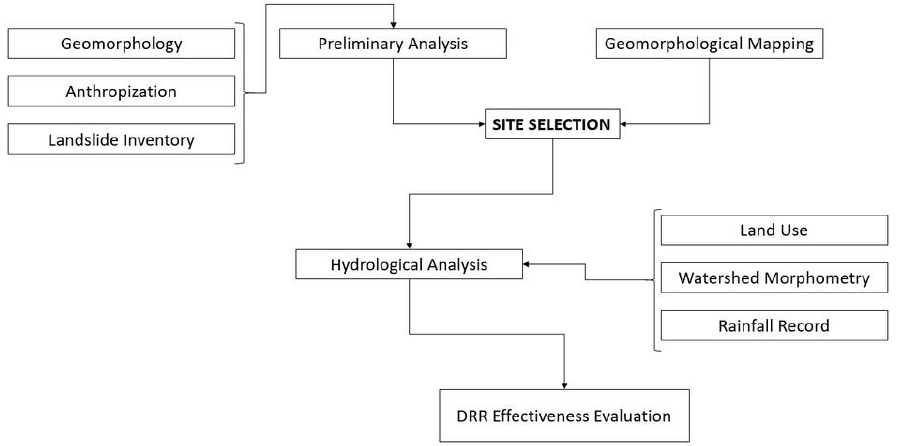
Geosciences 2022 , 12 , 260